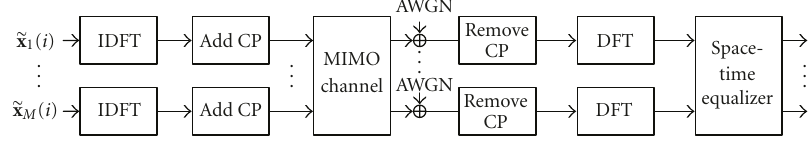
Figure 3: Block diagram of a MIMO OFDM